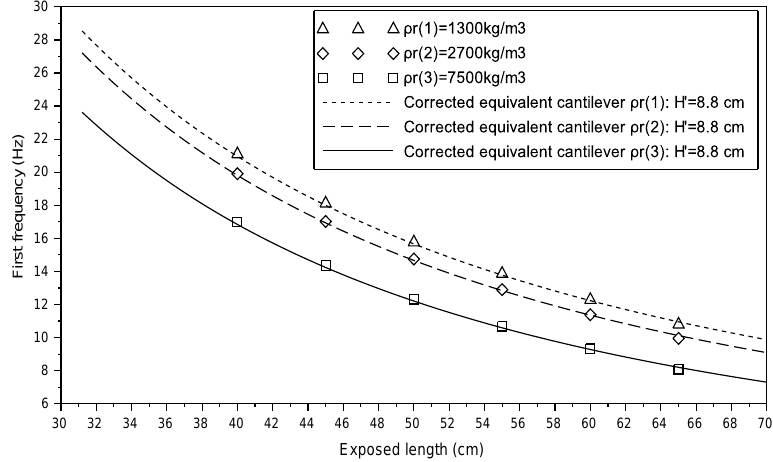
Figure 15. Variation of the adjustment length H (cid:48) with the bulk density of the rod ρ r